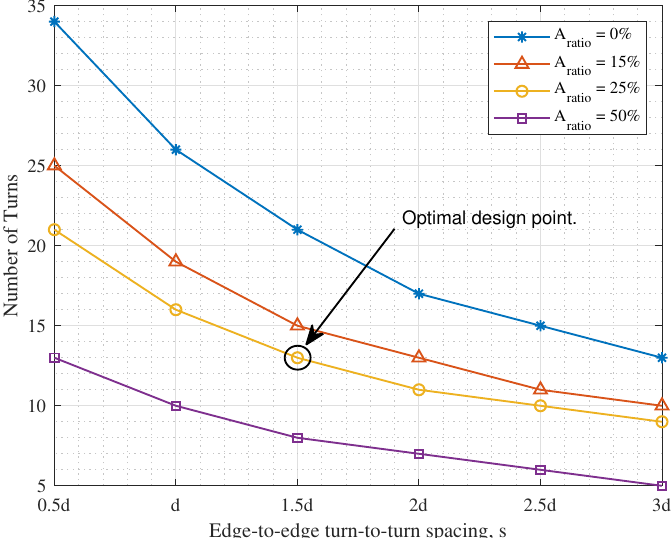
Figure 9. Relationship between N , s and A ratio for 800 × 600 mm 2 DD charging coils, with optimal design point identified.